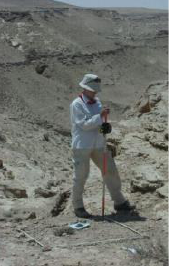
Figure 3. Detailed recording of Palaeolithic workshops with total station and a prism at Tar al-Sbai on Jebel Bishri. Photo: SYGIS